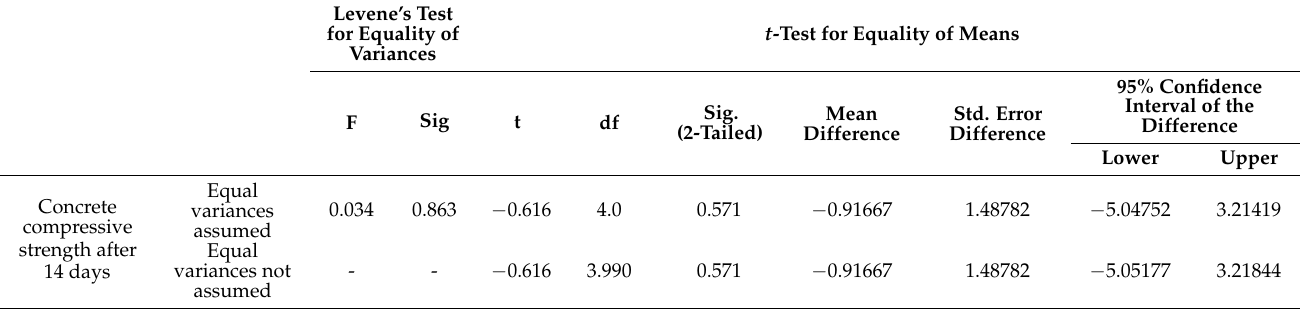
Table 11. Independent t -test for concrete compressive strength after 14 days.